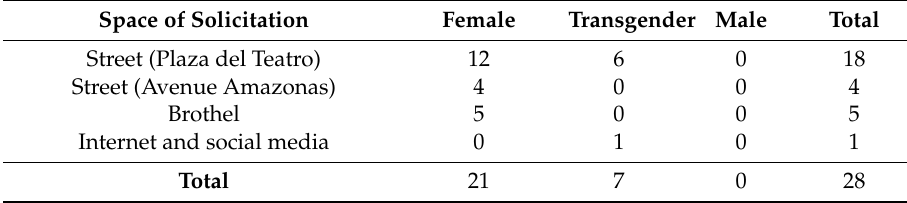
Table 3. Sex worker participant spaces of solicitation in Quito, Ecuador by